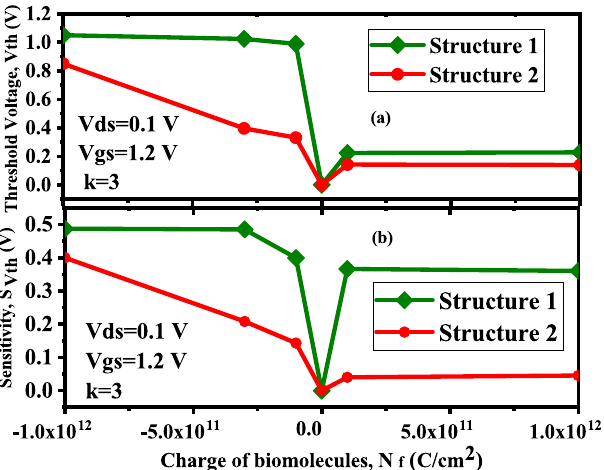
Figure 9. Threshold voltage and Sensitivity w.r.t to negatively and positively charged biomolecules for Device structure-1 and Device structure-2 ( V gs = 1.2 V , V ds = 0.1 V for κ = 3